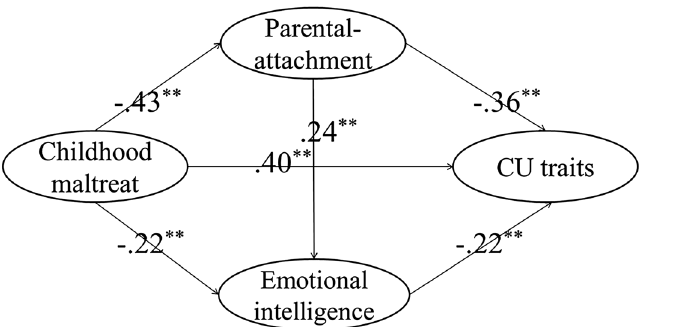
Figure 1. The final structural model.